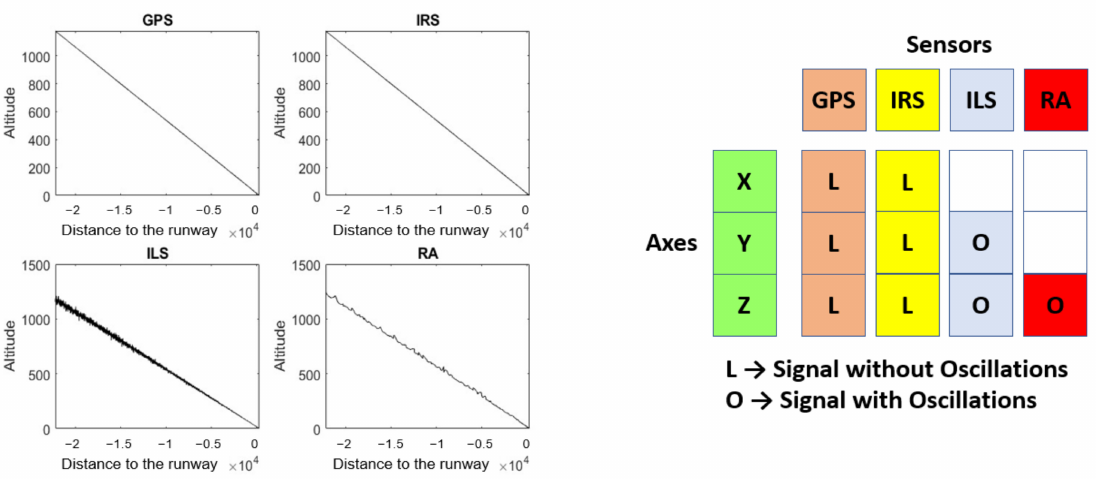
Figure 2. Example of simulated time series of the Z coordinate during the landing process: Z GPS , Z IRS , Z ILS , and Z RA . On the right side, a table relates each sensor to each coordinate. The sensor coordinate cell shows whether or not the signal has oscillations. There is no signal if the cell is empty.